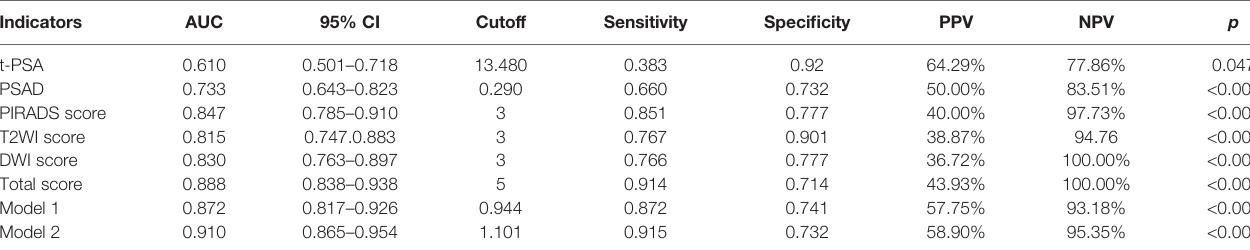
TABLE 4B | Comparison of the diagnostic performance of prediction models and clinical indicators in the validation group (csPCa).